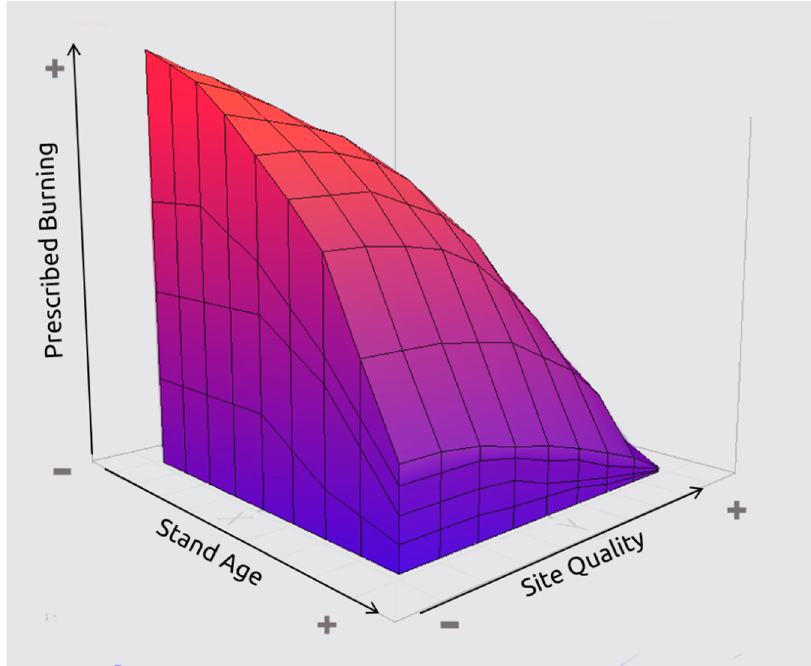
Figure 1. Illustration of biological factors influencing landowner participation in MSM. Areas on the diagram in red represent biological conditions where MSM could provide a viable management alternative, while areas in purple represent areas where adopting MSM is less favorable. Plus signs indicate an increase in site quality, stand age, and the ability to apply prescribed fire as a silvicultural tool. Minus signs indicate a decrease in site quality, stand age, and ability to apply prescribed fire as a silvicultural